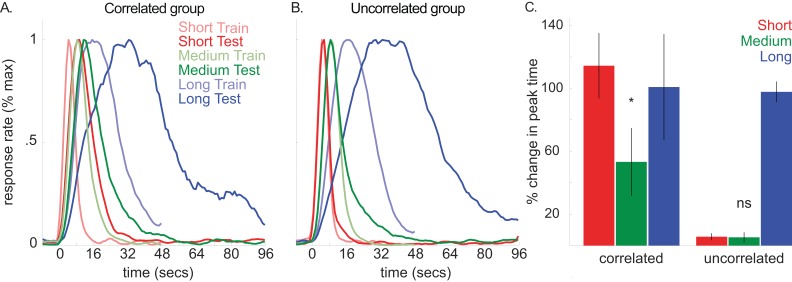
(A) and (B) show probe trial responding during initial training and testing for each cue in the correlated (n = 5) and uncorrelated (n = 5) groups of Experiment 4b, respectively.(C) shows percent change in peak time at test (±SEM) for both groups and all cues, relative to initial training.10.7554/eLife.38790.025Figure 6—figure supplement 1—source data 1.Data used to generate Figure 6—figure supplement 1.